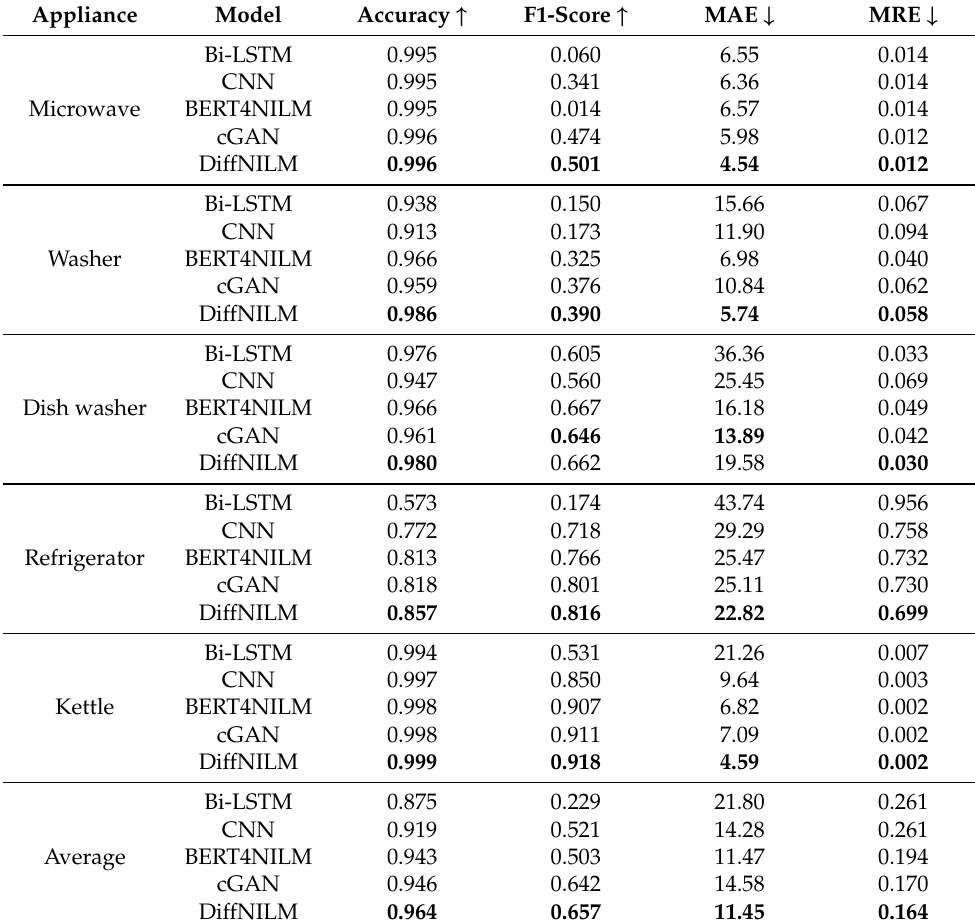
Table 4. Model performances on